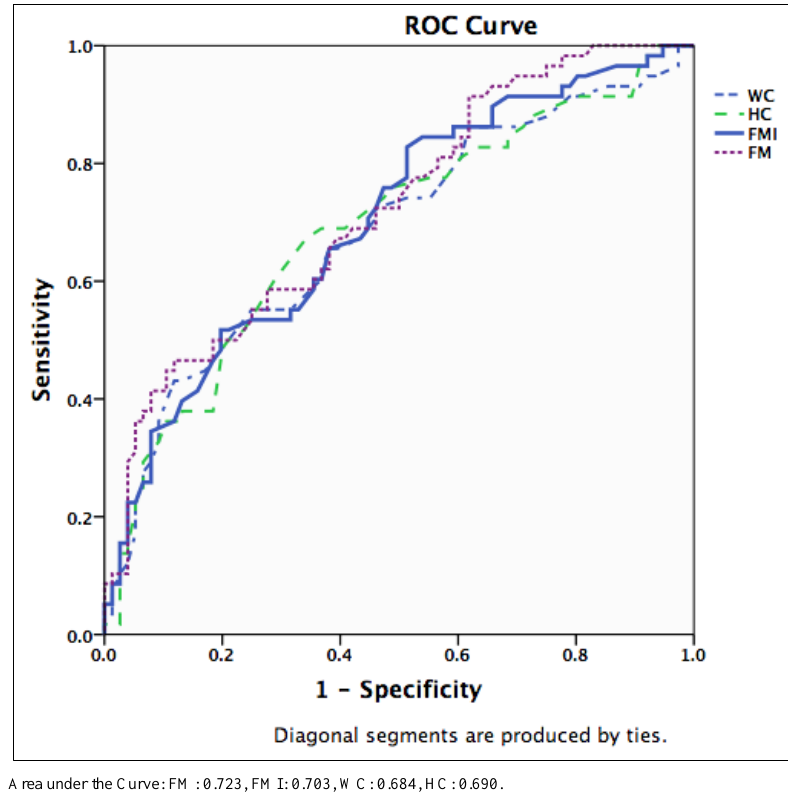
Figure 1. ROC curve analysis of fat mass, fat mass index and indirect methods according to fatty liver